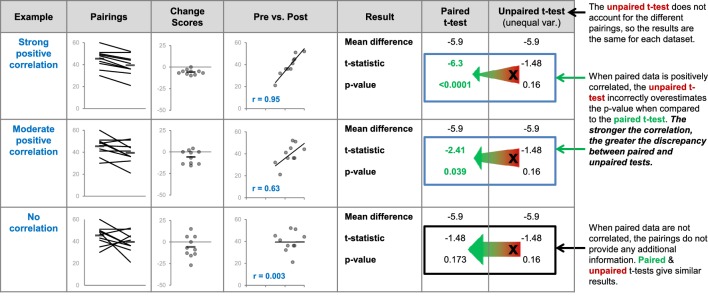
Differences between the results of statistical tests depend on the data.The three datasets use different pairings of the values shown in the dot plot on the left. The comments on the right side of the figure illustrate what happens when an unpaired t-test is inappropriately used to compare paired, or related, measurements. We expect paired data to be positively correlated – two paired observations are usually more similar than two unrelated observations. The strength of this correlation will vary. We expect observations from the same participant to be more similar (strongly correlated) than observations from pairs of participants matched for age and sex. Stronger correlations result in greater discrepancies between the results of the paired and unpaired t-tests. Very strong correlations between paired data are unusual but are presented here to illustrate this relationship. We do not expect paired data to be negatively correlated – if this happens it is important to review the experimental design and data to ensure that everything is correct.